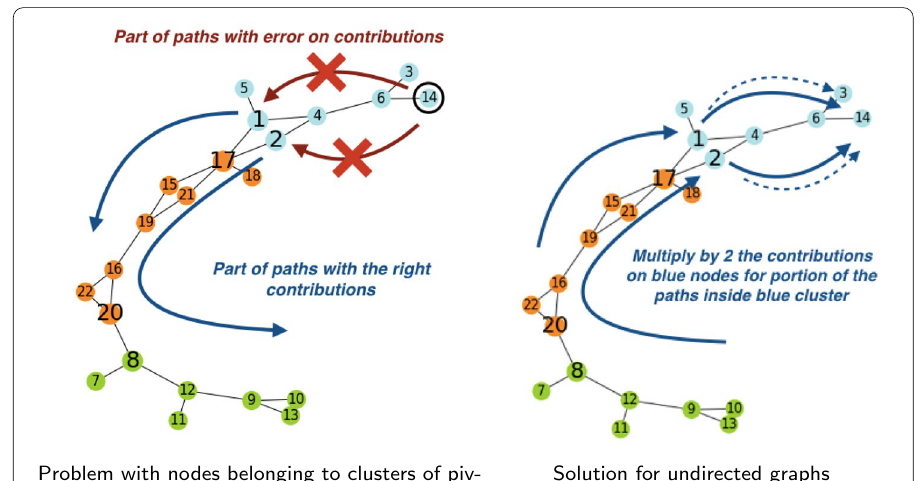
Fig. 4 Global SSSP explorations from